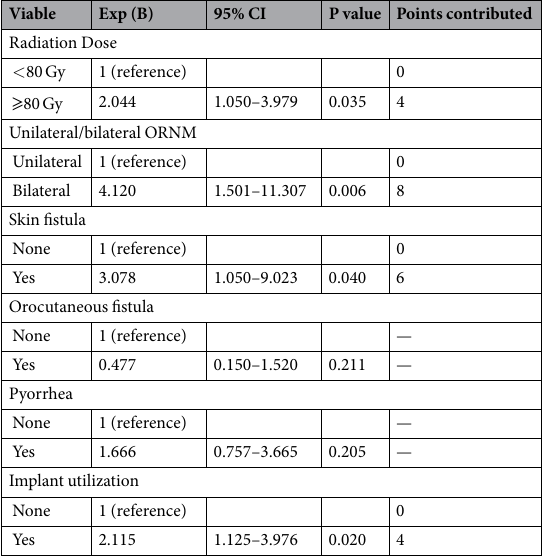
Table 6. Logistic regression analysis of significant factors detected in univariate analysis.